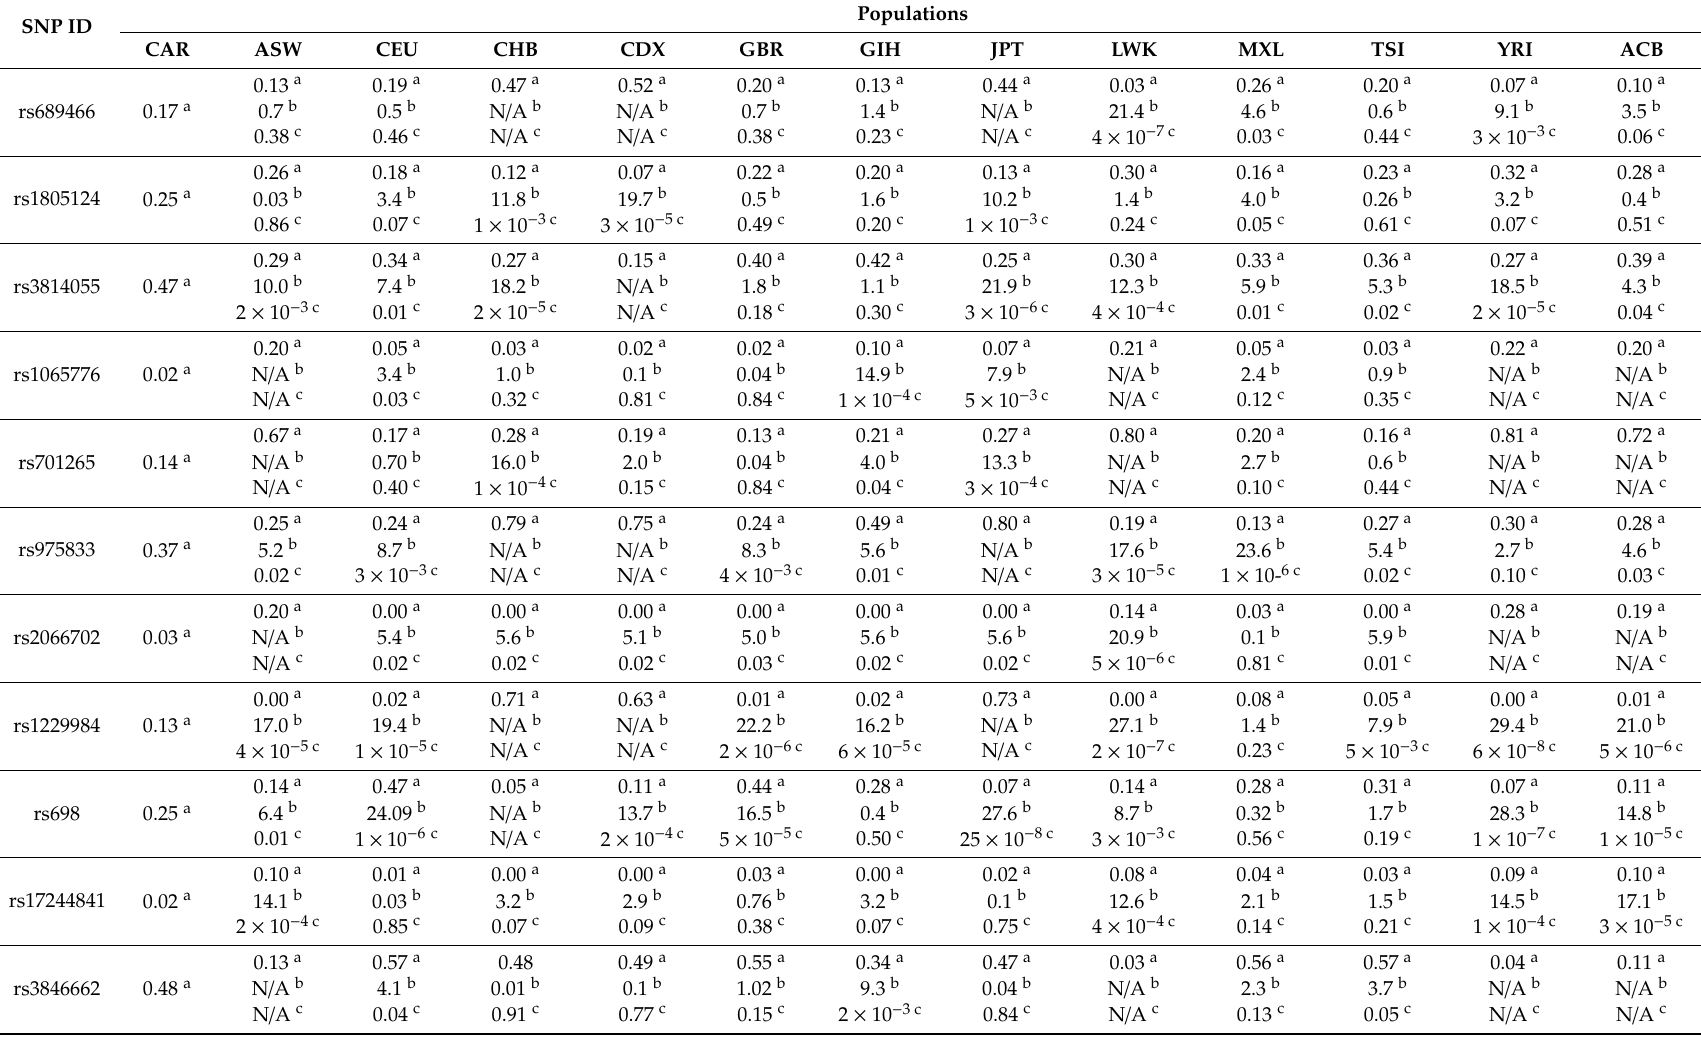
Table 3. Significant variants within several genes in Circassian compared to HapMap